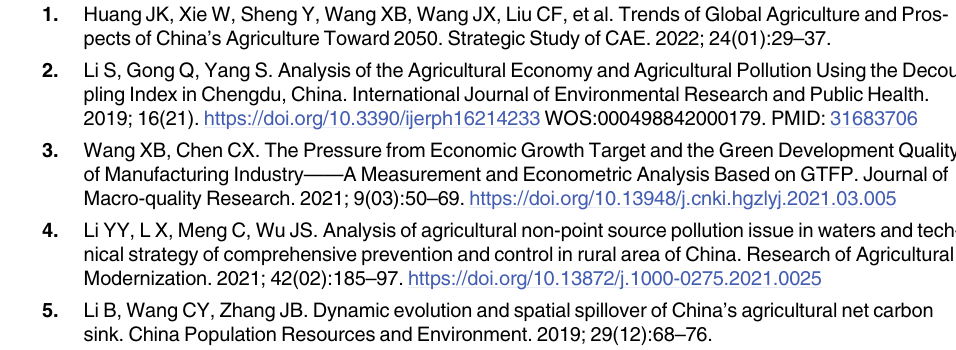
S1 Table. Decoupling agricultural pollution and carbon reduction from economic growth. S2 Table. Agricultural pollution-carbon emission-economic growth change rate. S3 Table. The synergy coefficients between agricultural pollution and carbon reduction in the Yangtze River Delta cities from 2011 to 2020. S4 Table. Predicted decoupling of agricultural pollution and carbon reduction from eco- nomic